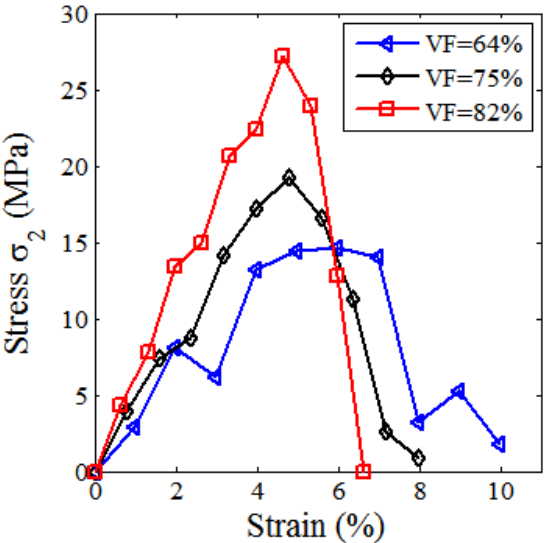
Figure 5. Stress–strain curves at different grain volume fraction. The results indicate that ultimate stress will increase as the grain volume fraction increases.